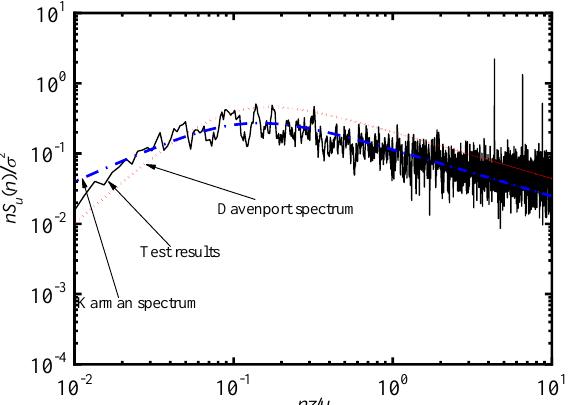
Figure 1. The distribution of mean wind speed and turbulence intensity along height. ( a ) The distri- bution of mean wind speed along height. ( b ) The distribution of turbulence intensity along height.